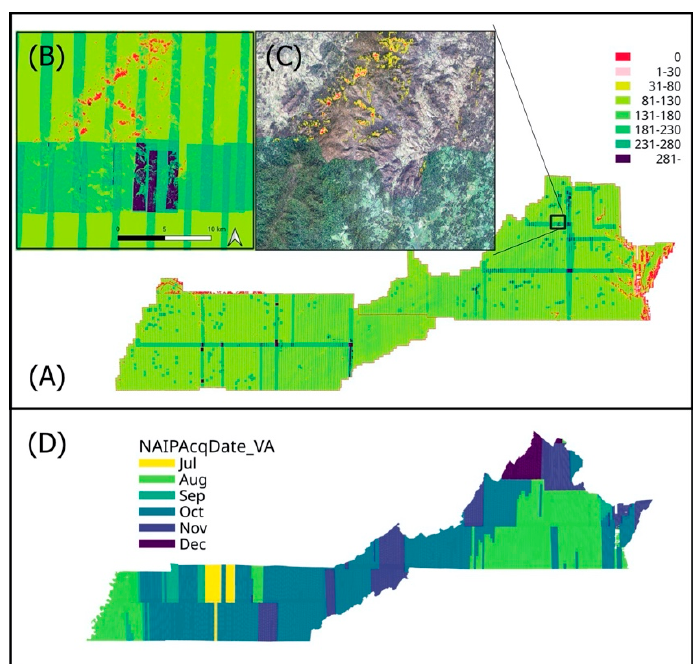
Figure 3. NAIP point cloud density and acquisition month. ( A ) Point density raster showing the number of 3D NAIP points in each 10-m grid cell. ( B ) A zoomed view of the point density raster. ( C ) A zoomed view of the NAIP imagery natural color composite. ( D ) NAIP imagery acquisition month.